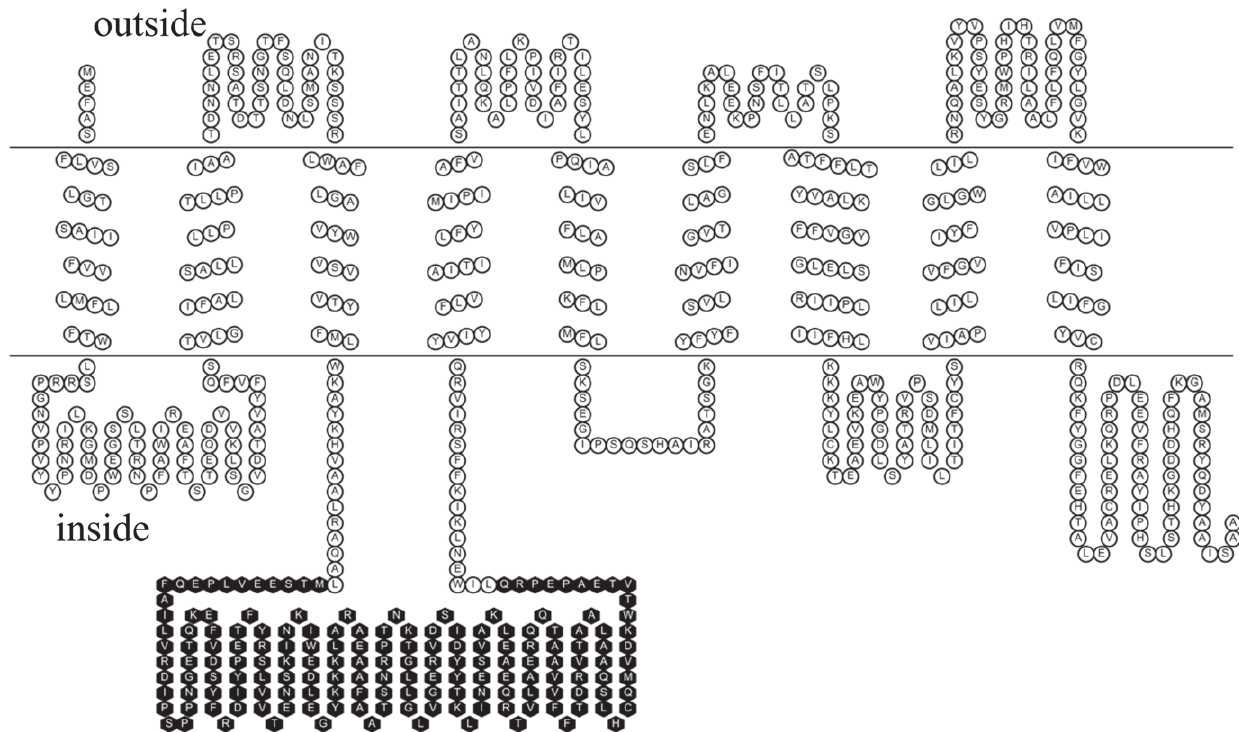
Figure 4. The topology of the B.juncea ERD4 protein. The toplogy was drawn using TOPO2 tools. The nine transmembrane helices are shown. Also, shown (filled hexagons) is the globular domain containing RNA-recognition domains. The globular domain is suggested to reside inside the chloroplast.